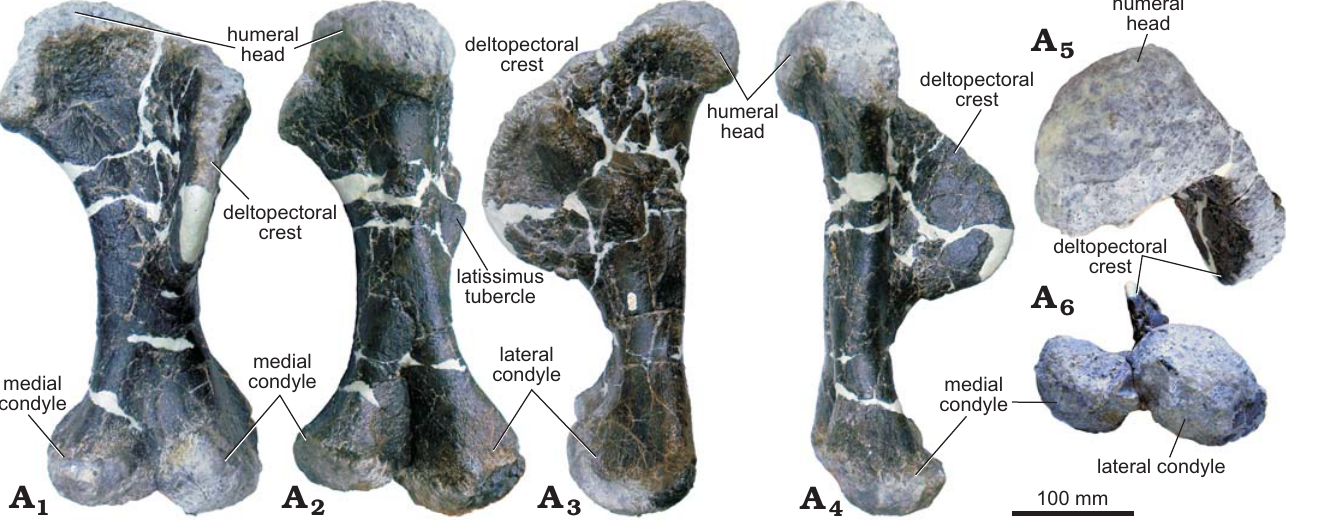
Fig. 15. Left humerus of stegosaur GPDM 178, near Giffen, Cascade County, Montana; in anterior (A 1 ), posterior (A 2 ), lateral (A 3 ), medial (A 4 ), dorsal (A 5 ), and ventral (A 6 )